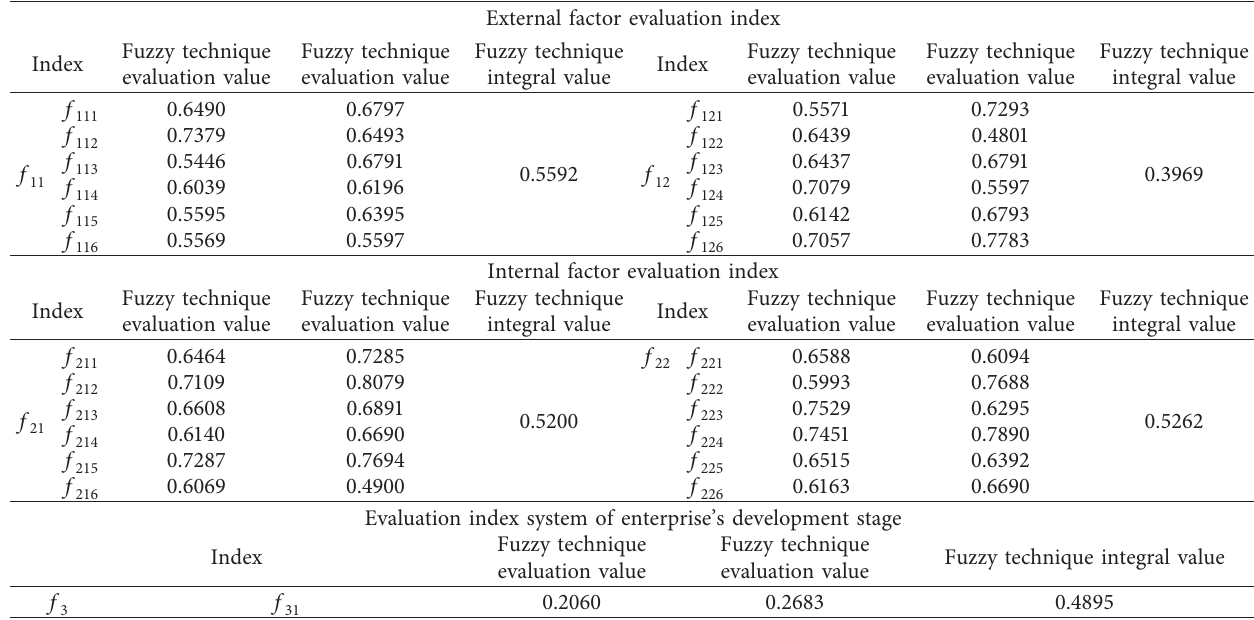
Table 5: ARR advance intelligent manufacturing-planned strategic path four-level index and fuzzy technique integral value.